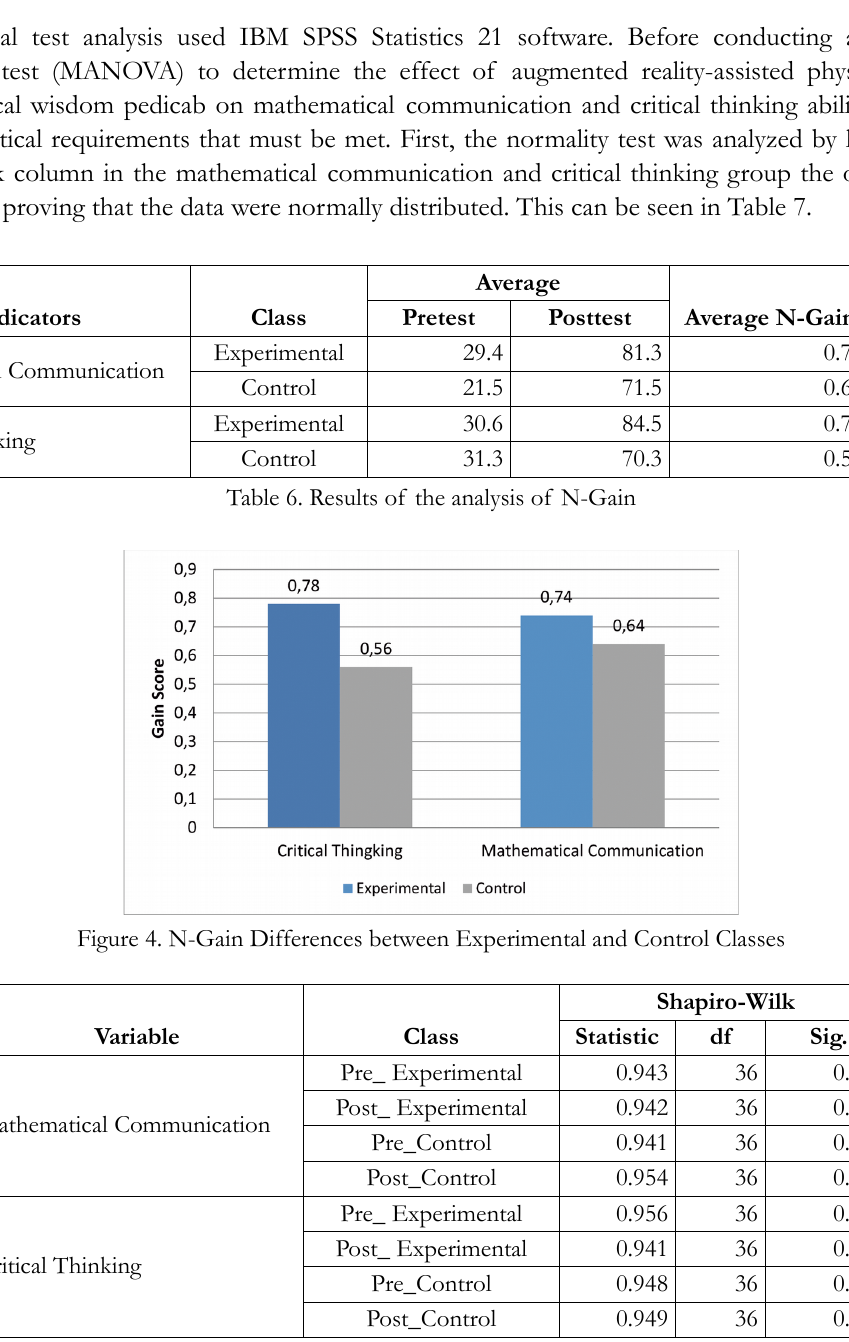
Table 7. Result of normality